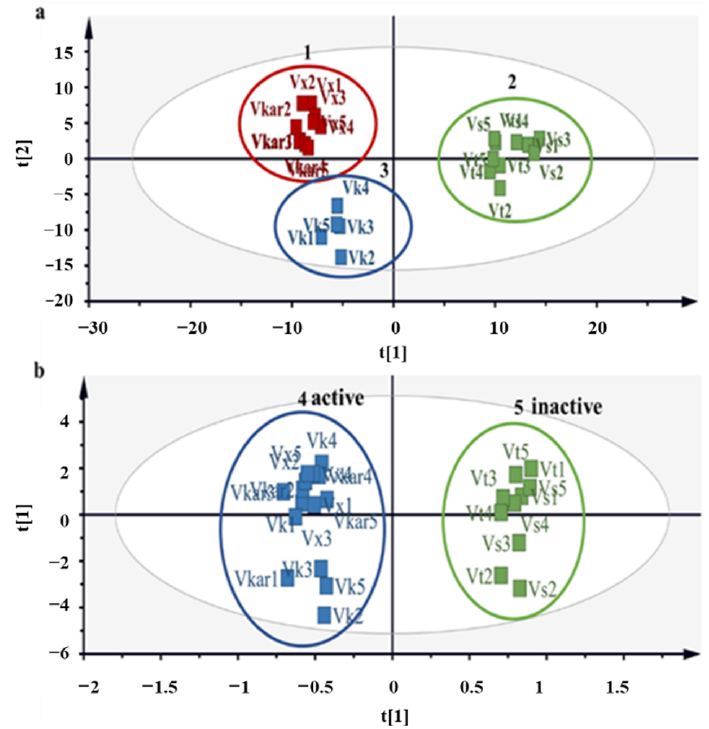
Figure 2. A representation of the PCA score plot ( a ) and OPLS-DA ( b ) score plot showing the separation of the plant extracts with high activity in blue (Vx, V. xanthophloea ; Vkar, V. karroo ; Vk, V. kosiensis ) and less active samples in green (Vs, V. sieberiana ; Vt, V. tortilis ). Extracts with IC 50 ≤ 10